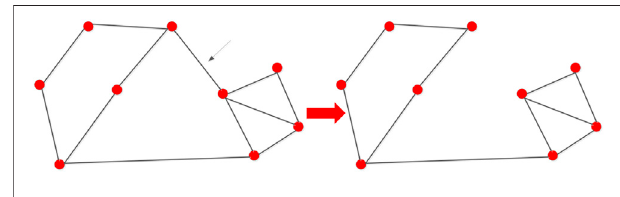
FIGURE 2 | Edge ’ s disturbance schematic diagram.